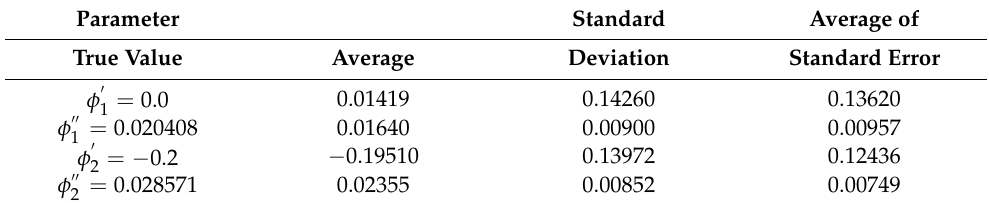
Table A2. Theoretical values of the parameters, averages and standard deviations of the estimates across simulations and averages across simulations of the estimated standard errors φ (cid:48) φ (cid:48)(cid:48) for the tdAR(2) model described above for n = 50 and 934 replications (out of 2